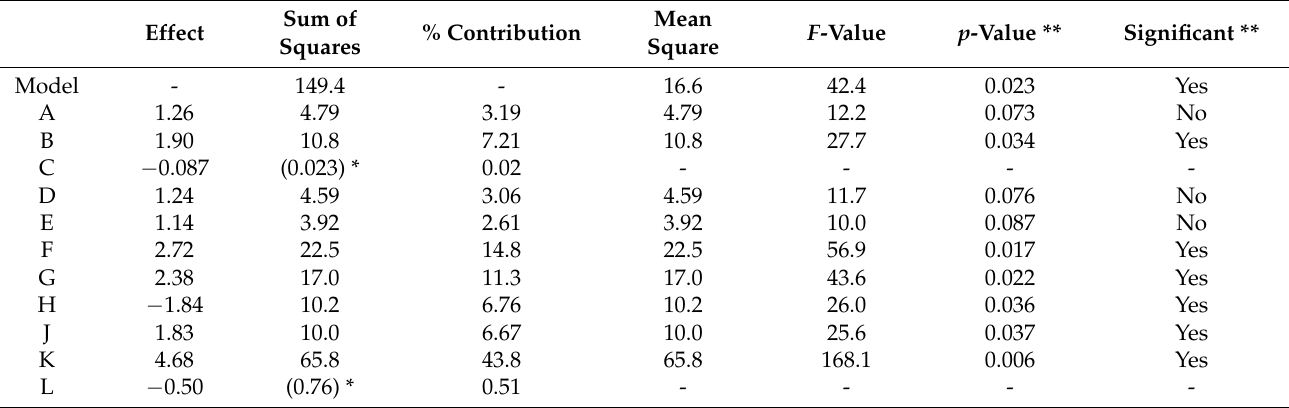
Table 4. Standardized effect and ANOVA analysis for PBD.